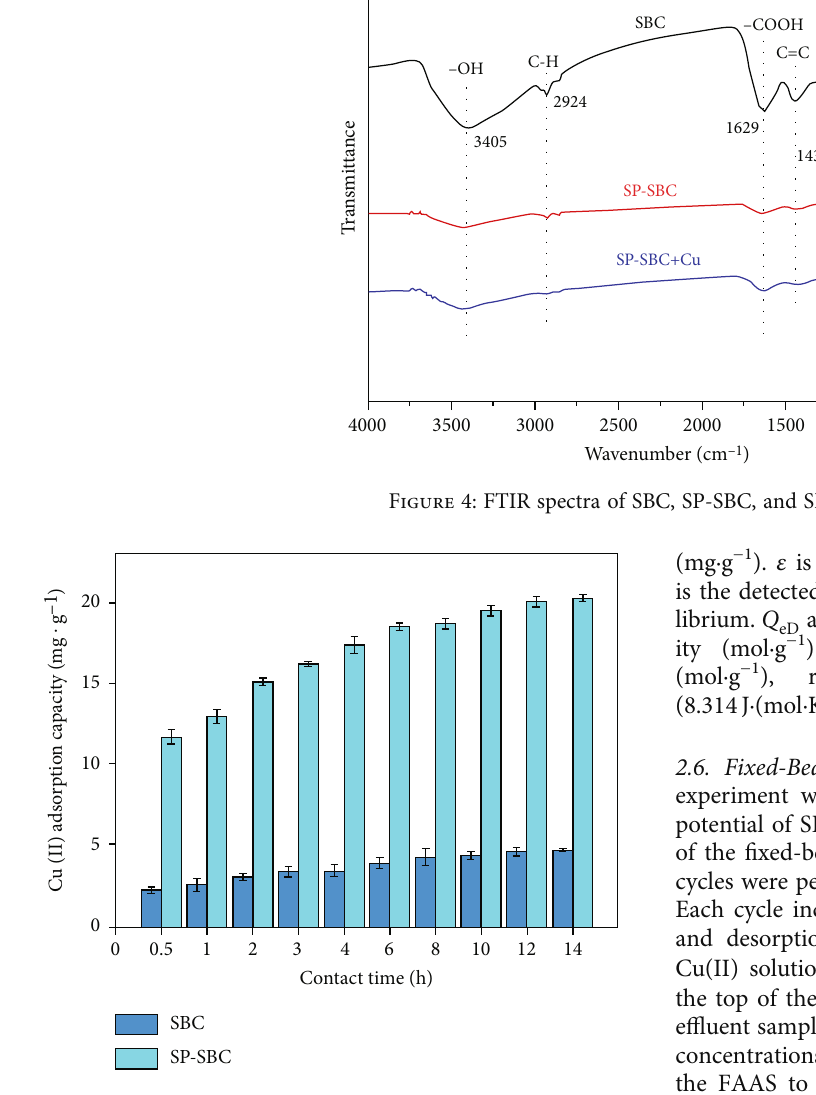
Figure 5: Adsorption capacities of SBC and SP-SBC for Cu(II) at di ff erent contact